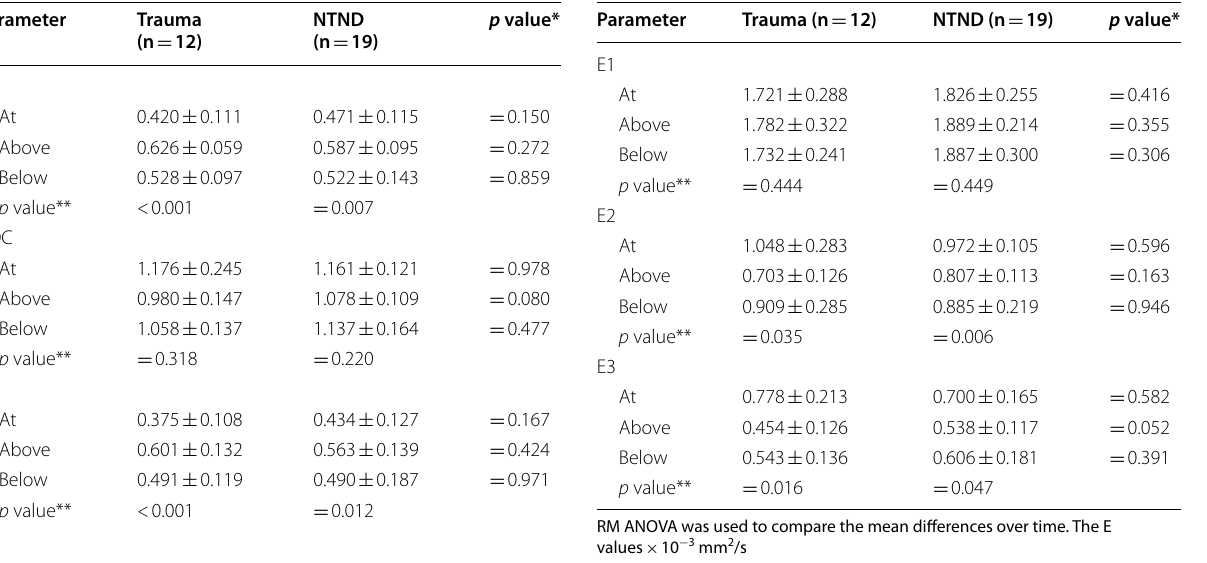
Table 2 Repeated‑measures ANOVA test comparing the difference in the calculated mean of different DTI metrics within the same group of pathology and between different pathology groups along the study cohort